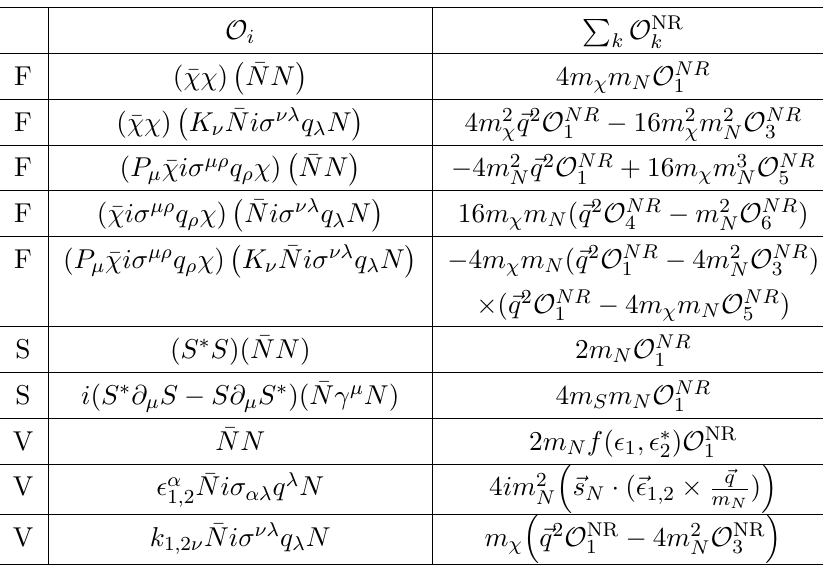
Table 1 . E(cid:11)ective operators for fermion (F), scalar (S) and vector (V) dark matter. the detailed form of which is given in eq.